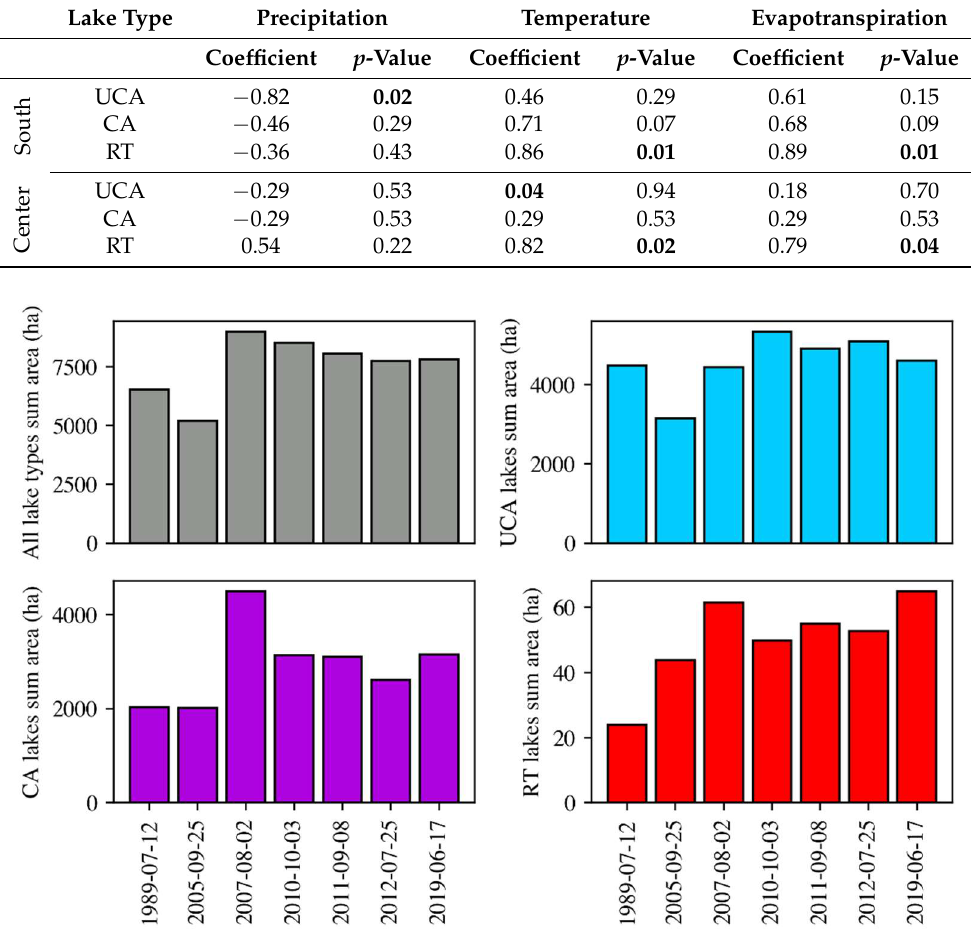
Figure 12. Histograms of lake surface area for the south study site for all lake types (gray), UCA lakes (blue), CA lakes (magenta), and RT lakes (red).